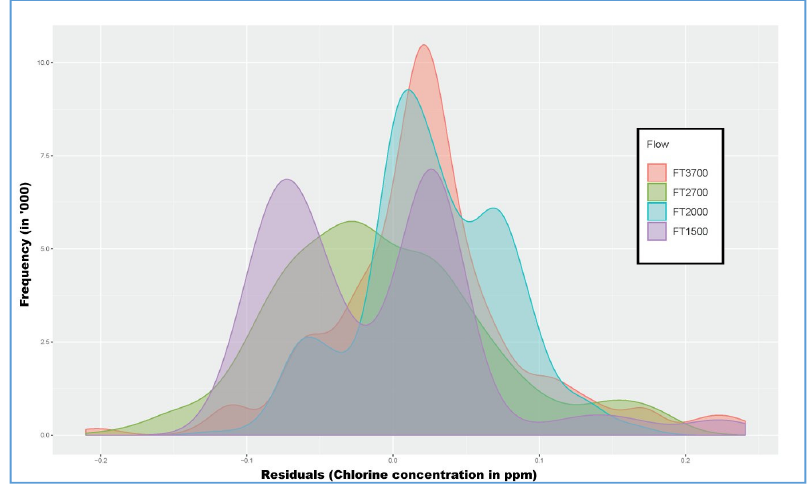
Figure 14. Plot of residuals for different flow rate operating points (1.5, 2.0, 2.7, and 3.7 m 3 /s).